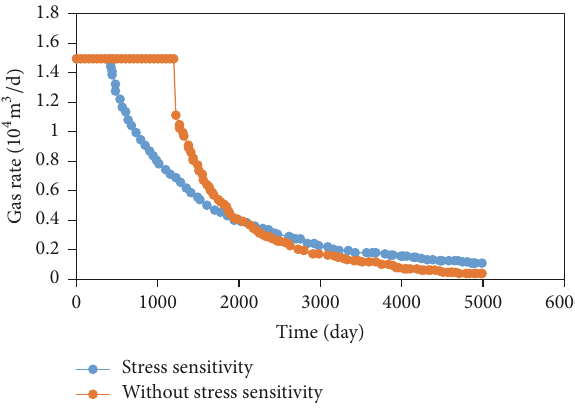
Figure 8: Effect of TPG on cumulative gas production.